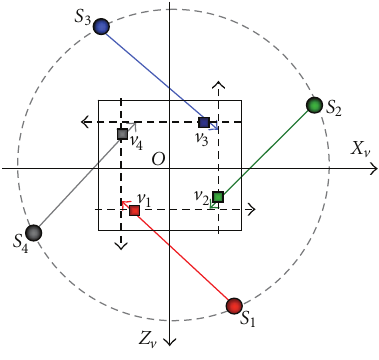
Figure 3: Rotational symmetry in projection